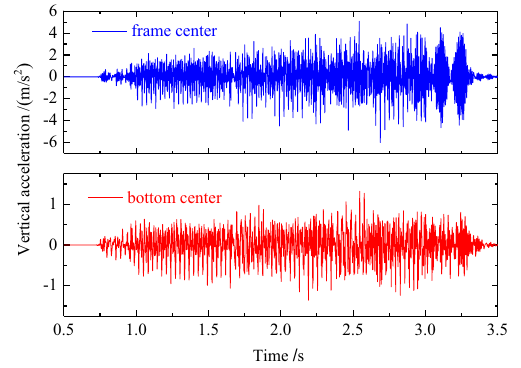
Fig. 9 The vertical acceleration time–history curves of at-ground structure